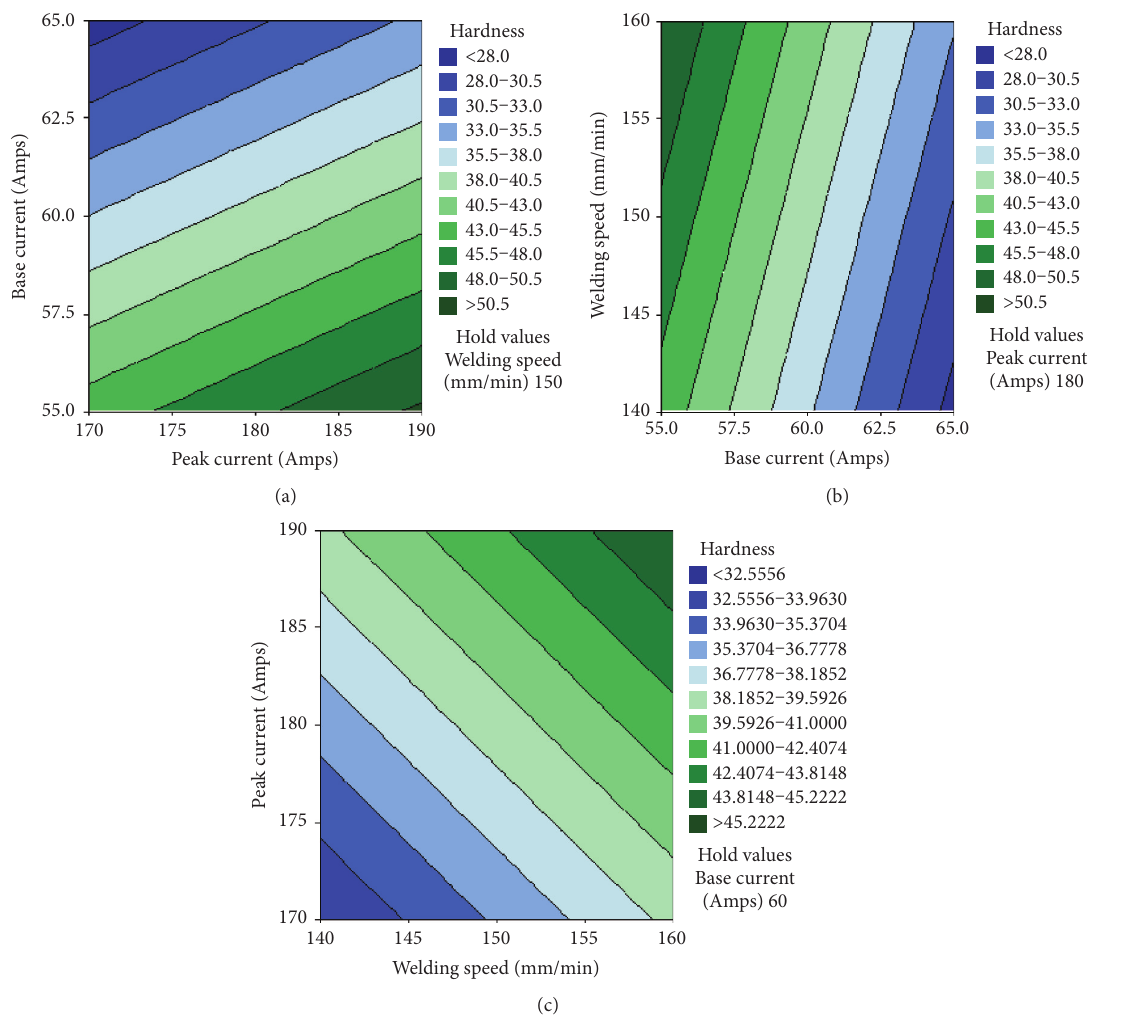
Figure 16: (a) Contour plot of hardness vs. peak current. (b) Contour plot of hardness vs. peak current, base current, and welding speed. (c) Contour plot of hardness vs. welding speed and peak